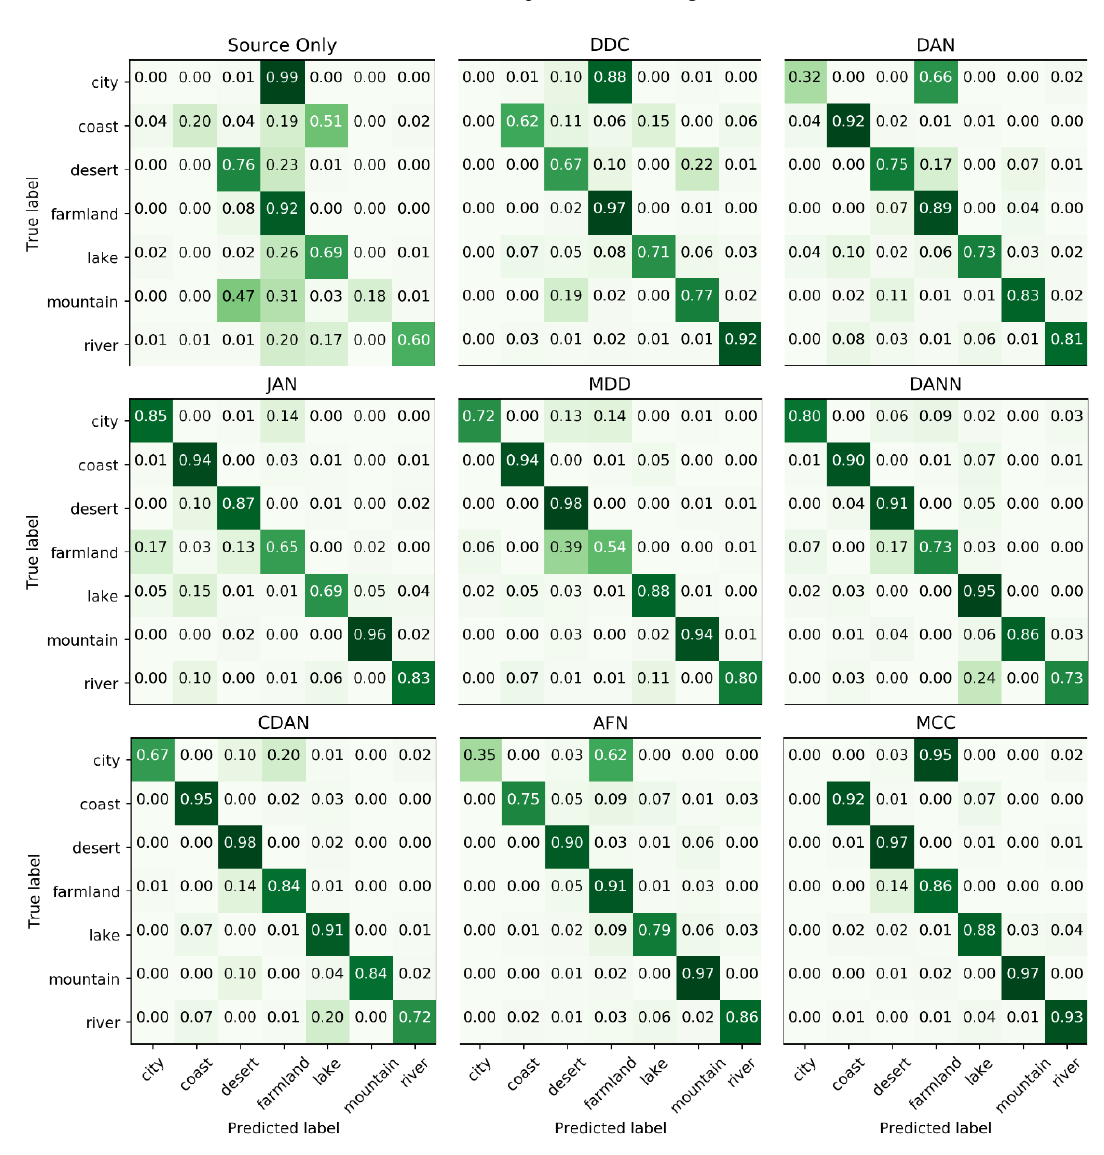
Figure 6 . Confusion matrix of nine classification